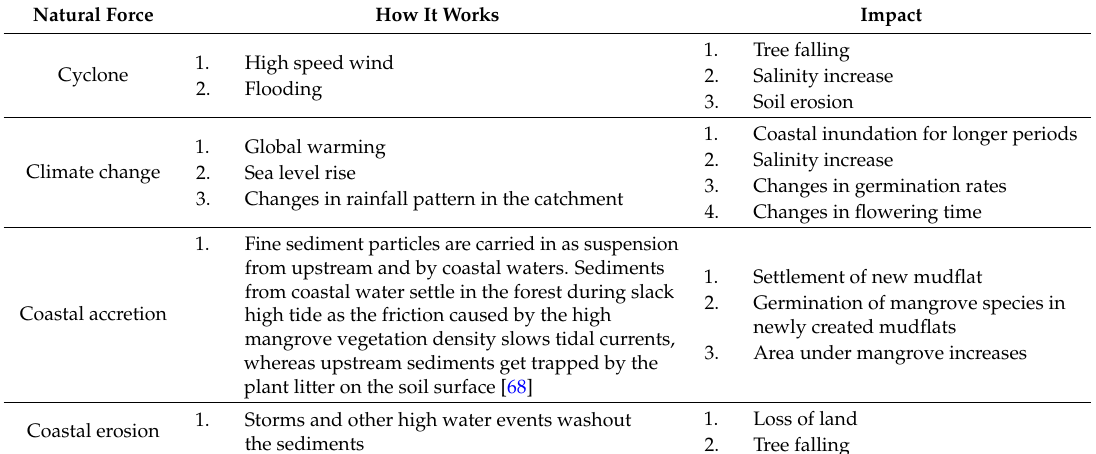
Table 5. Mechanism underlying the impact of different natural forces on mangrove forests.